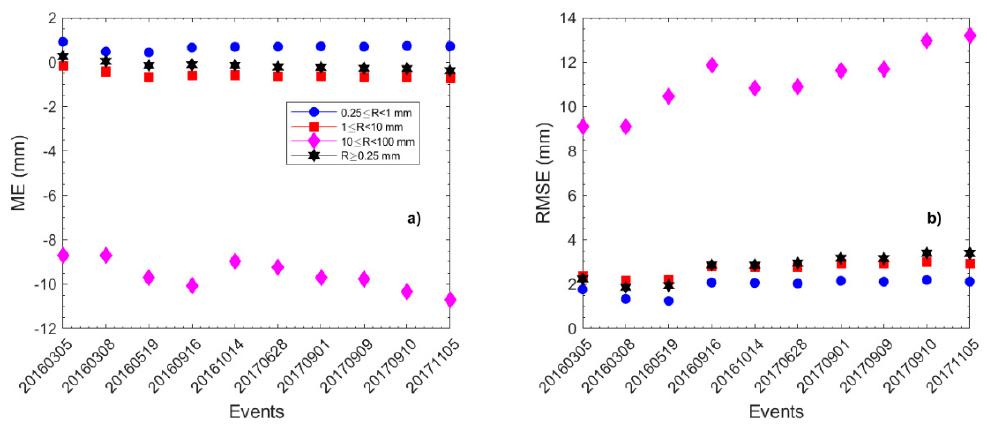
Figure 9. ( a ) Mean error (ME) and ( b ) root mean square error (RMSE) scores calculated by comparing the RAINBOW outputs with the GRISO data (taken as reference) on a regular 0.25° × 0.25° grid for 10 case studies. A minimum cumulated rain threshold is set at 0.25 mm and three different intervals of cumulated rain are considered: light 0.25–1 mm, moderate 1–10 mm, and heavy 10–100 mm.